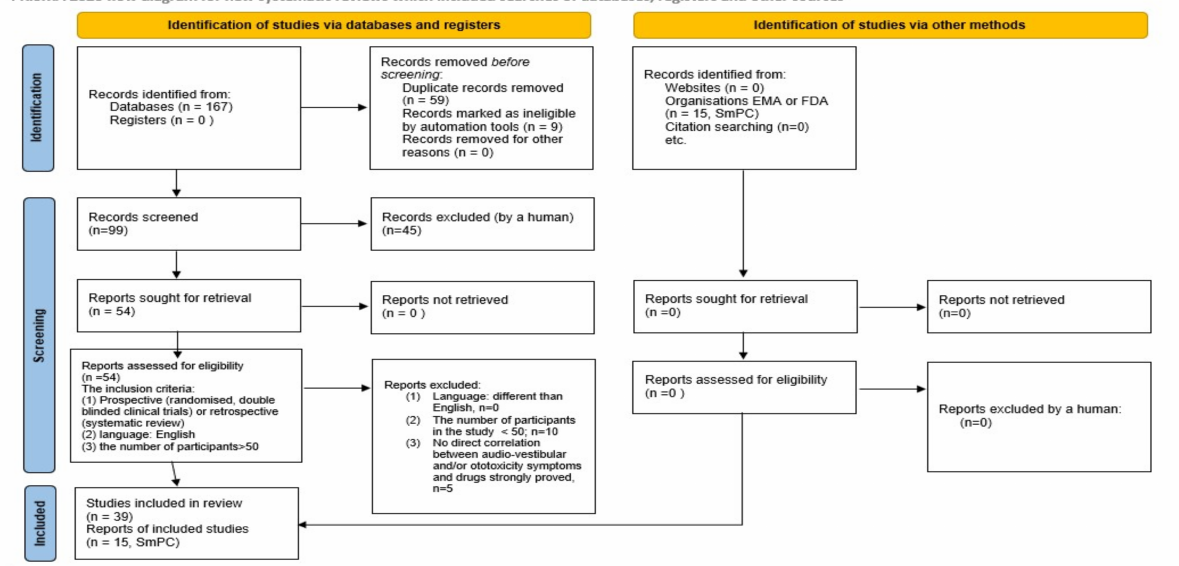
Figure 2. PRISMA flow diagram, outlining the identification, screening, eligibility, and inclusion criteria of the review